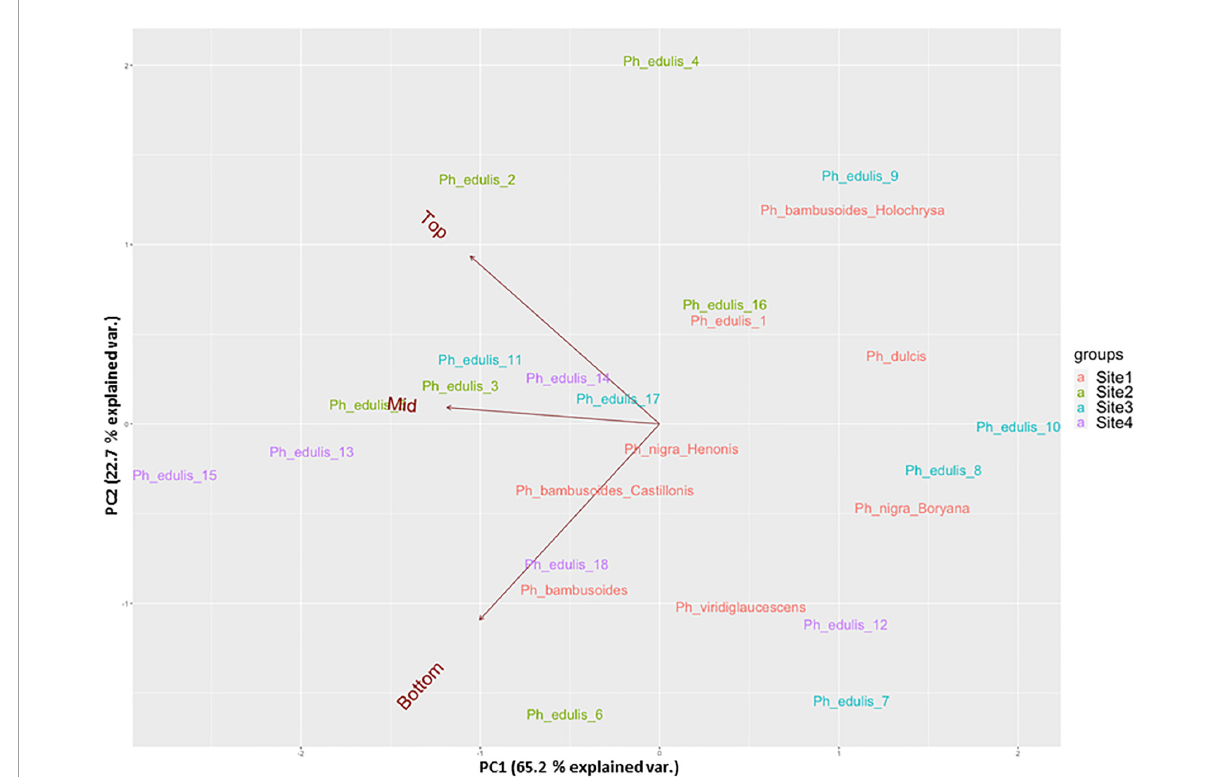
FIGURE5 Principal component analysis (PCA) in a biplot of splitting strength trait of the three parts of bamboo culm (variables: dark red) of 25 bamboo genotypes collected from 4